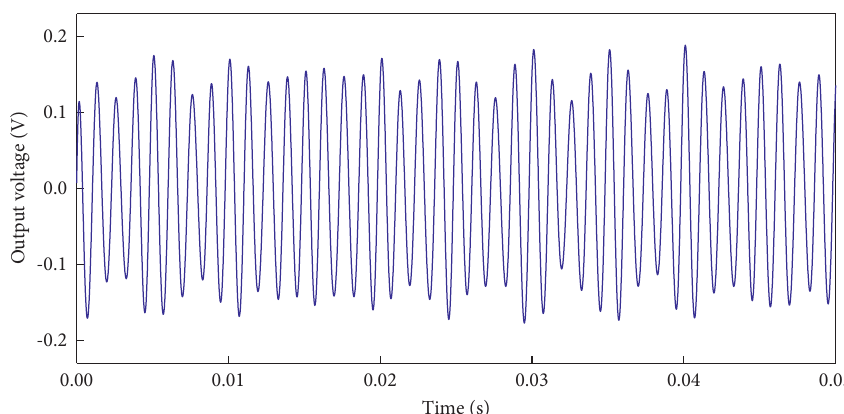
Figure 14: Output voltage of harvester under urban railway